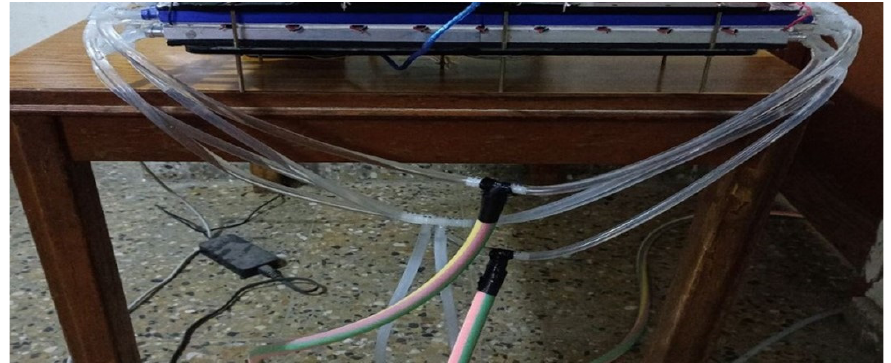
Figure 5. Pipes and integration of the system.